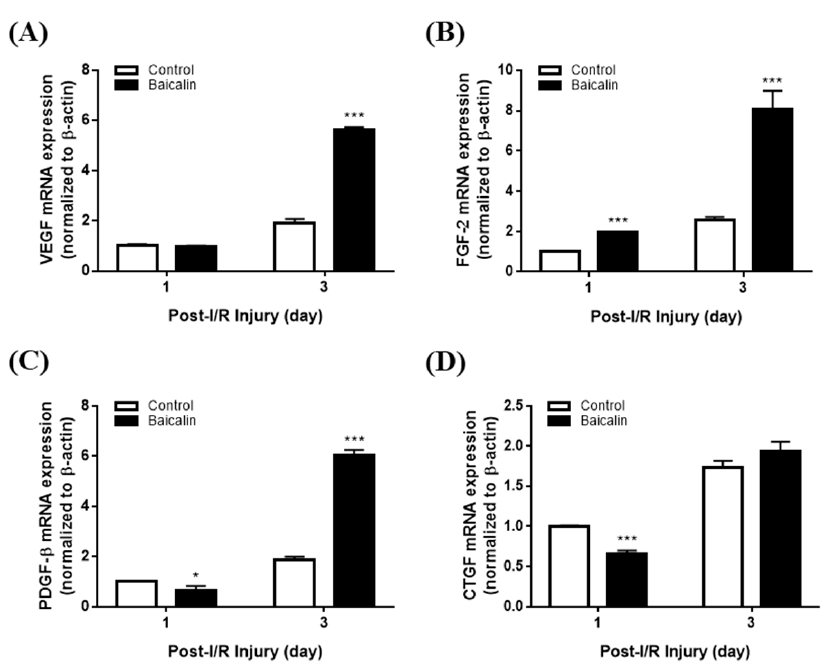
Figure 7. Gene expression levels of ( A ) VEGF, ( B ) FGF-2, ( C ) PDGF- β , and ( D ) CTGF, proangiogenic markers, in mice with pressure ulcers treated with baicalin. The expression levels of VEGF, FGF-2, and PDGF- β were significantly elevated in the baicalin group compared to the control group. All data are expressed as mean ± SD from three independent experiments. * p < 0.05, *** p < 0.001. VEGF, vascular endothelial growth factor; FGF-2, fibroblast growth factor-2; PDGF- β , platelet-derived growth factor- β ; CTGF, connective tissue growth